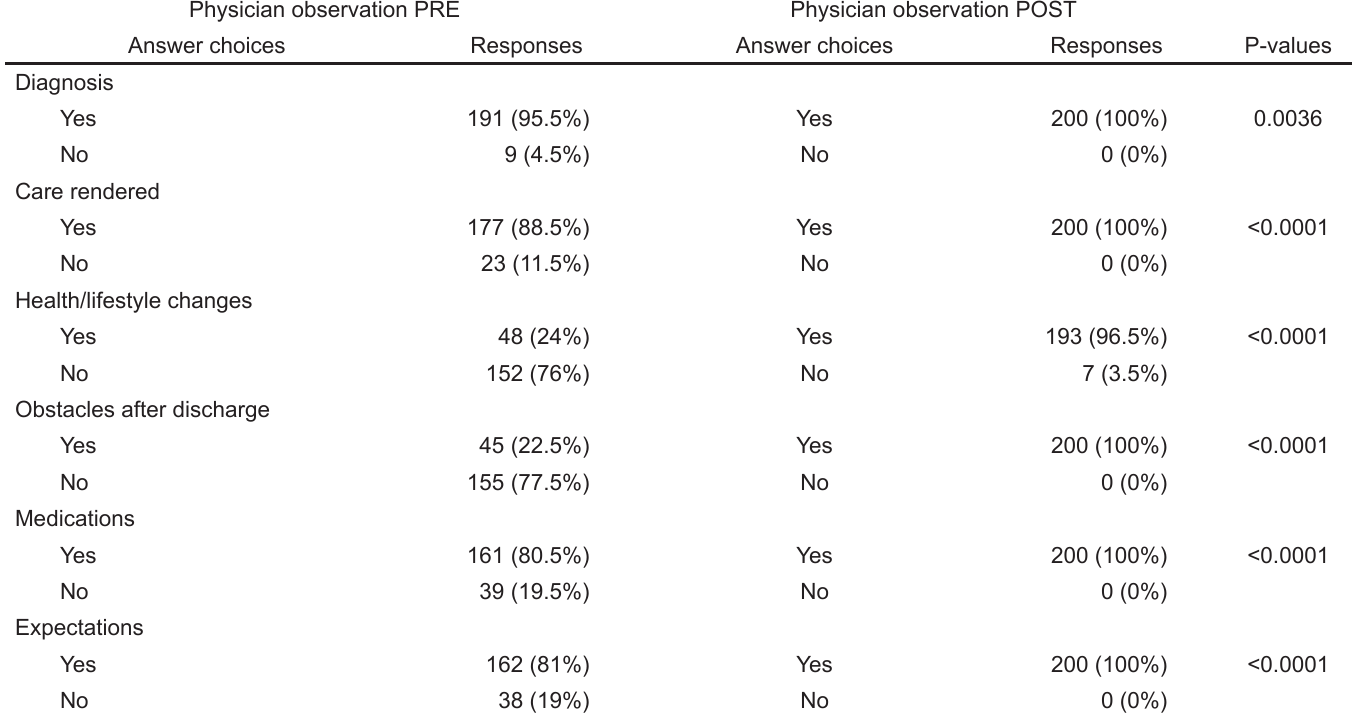
Differences between pre- and post-intervention were analyzed with Fisher’s exact test. P-values ≤0.05 were considered as statistically